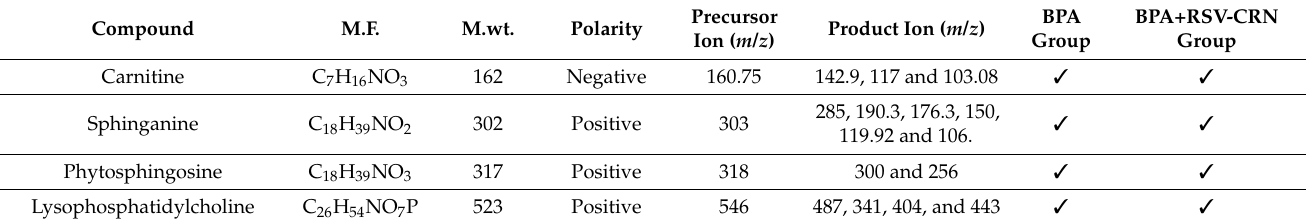
Table 2. Lipids identified in the MS/MS spectra of mice serum.